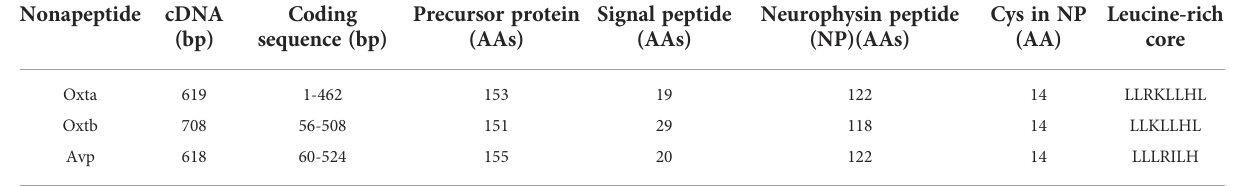
The mature nonapeptide hormone moiety (9 AA), cleavage site (GKR), and the domain between signal peptide and neurophysin are not